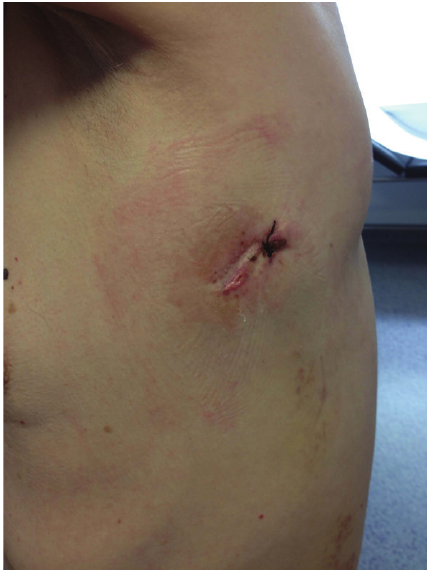
Figure 1: Postoperative result of single incision.